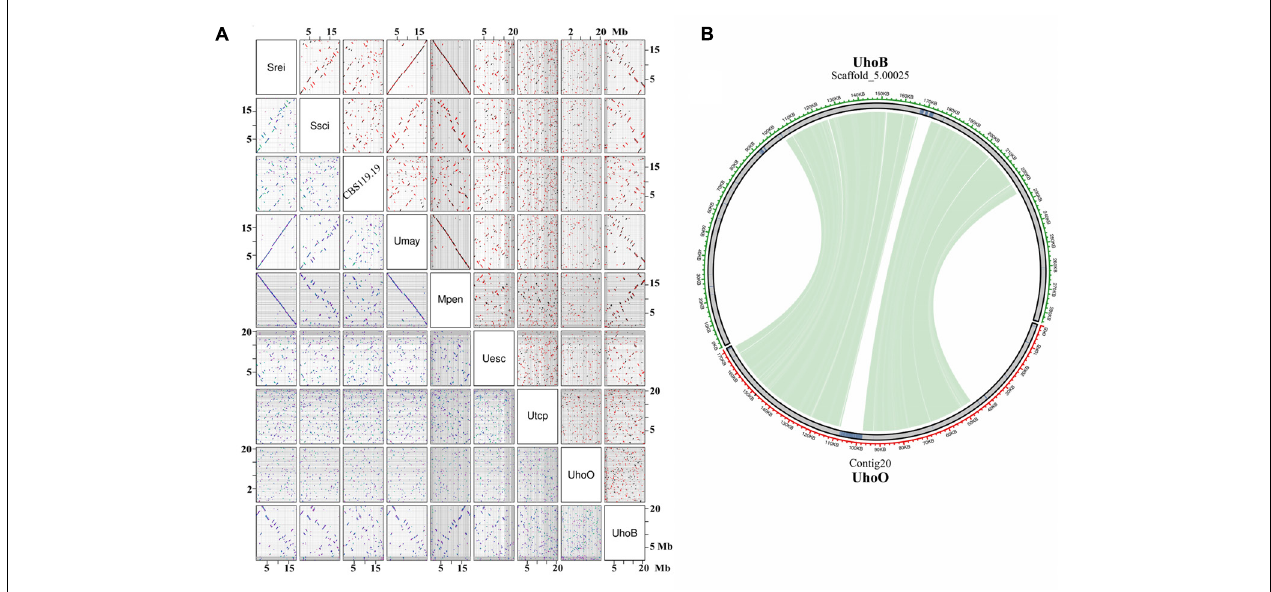
FIGURE 3 | Synteny between smut genomes. (A) Pairwise dotplot showing the syntenic blocks between smut genomes. The scientific names were abbreviated according to Table 1 . Axes represent the concatenation of repeat-masked chromosomes or scaffolds of each species (Mb scale). Grid lines indicate the boundaries between scaffolds. Dots in the upper diagonal correspond to regions of sequence similarity, where black color represents forward matches and red color represents reverse-complement matches. Dots in the lower panel are color-coded by the alignment score, with green meaning higher score and blue/purple lower score. (B) Circos-plot of U. hordei (oats) largest scaffold showing the syntenic region in U. hordei (barley) scaffold. Green lines connecting scaffolds correspond to blastn searches using repeat-masked scaffolds. Repetitive regions are shown in blue.